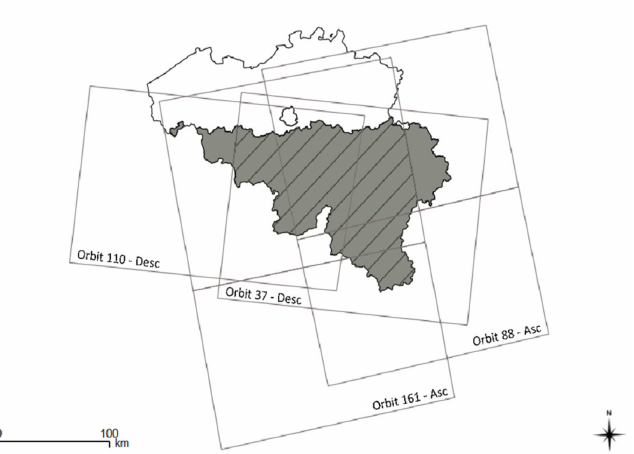
Figure 1. Walloon Region (South part of Belgium) and the Sentinel-1 orbits covering the biggest parts of the Walloon